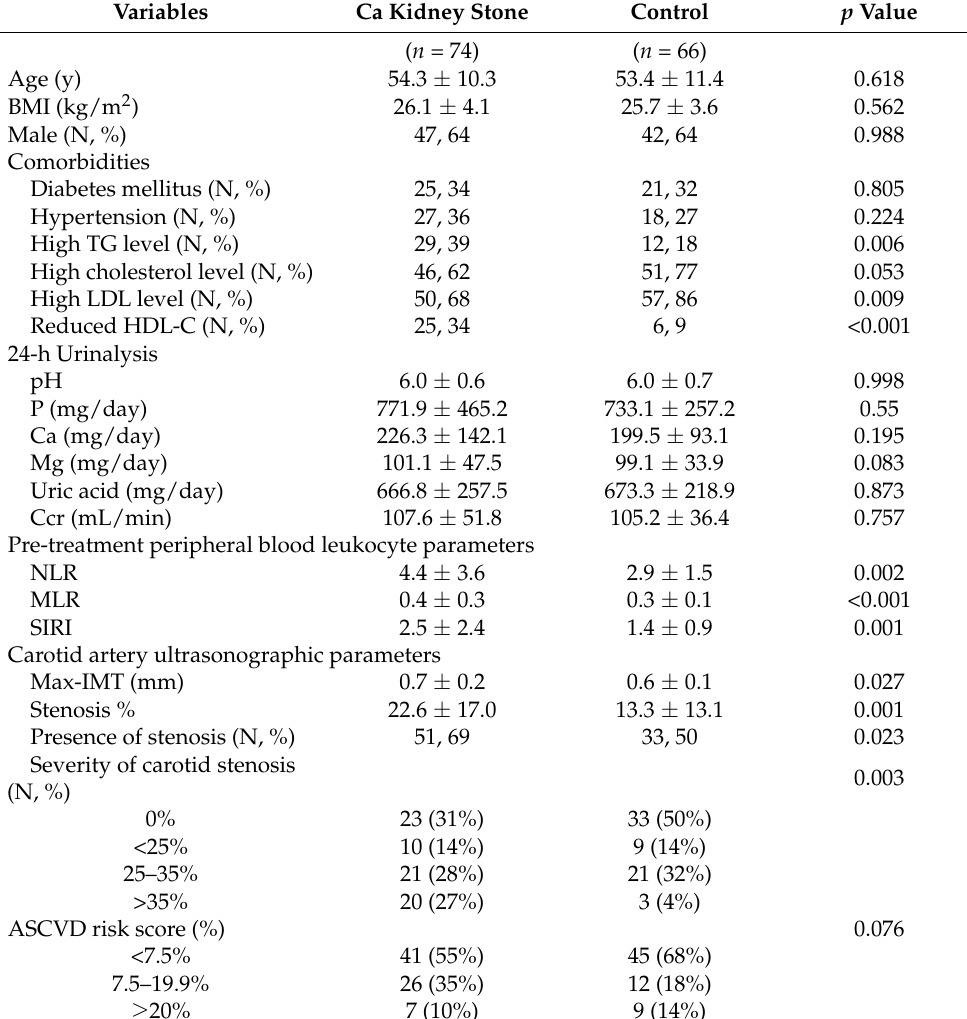
Table 1. Comparison of basic data, 24 h urinary biochemistry, pre-treatment serum inflammation markers, and cardiovascular risk between patients with and without calcium-containing stone. Data presented as mean ±